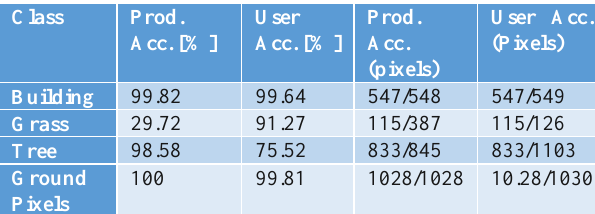
Table 2. Post classification of SVM classification method on the hyperspectral